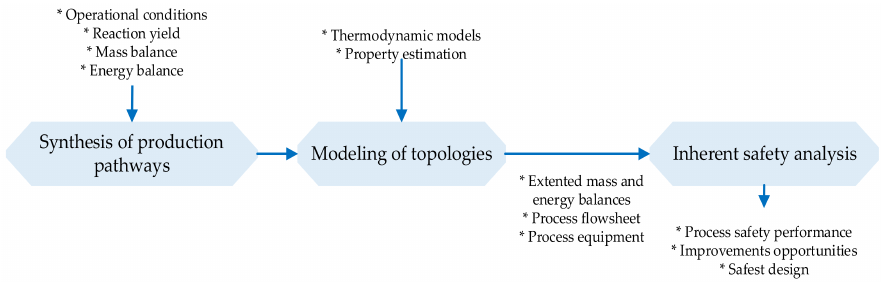
Figure 1. Schematic representation of the methodology.